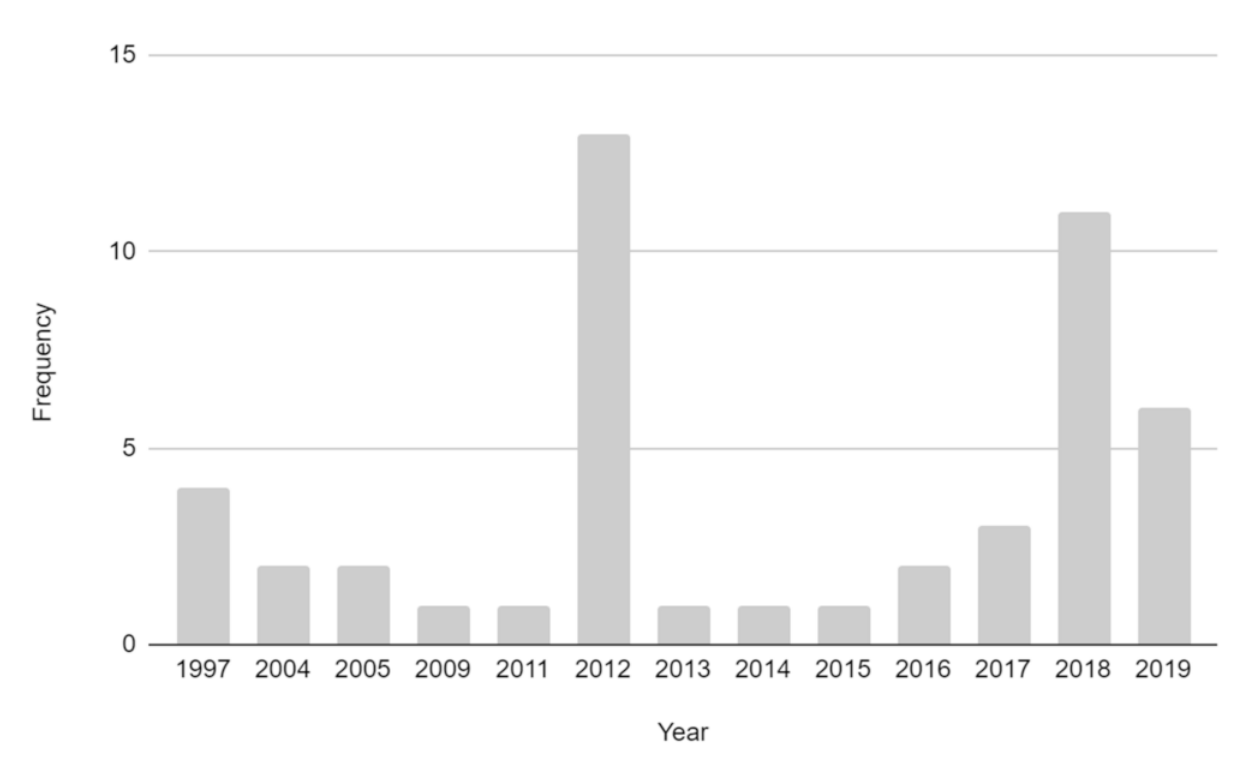
Figure 5. Year of study publication.